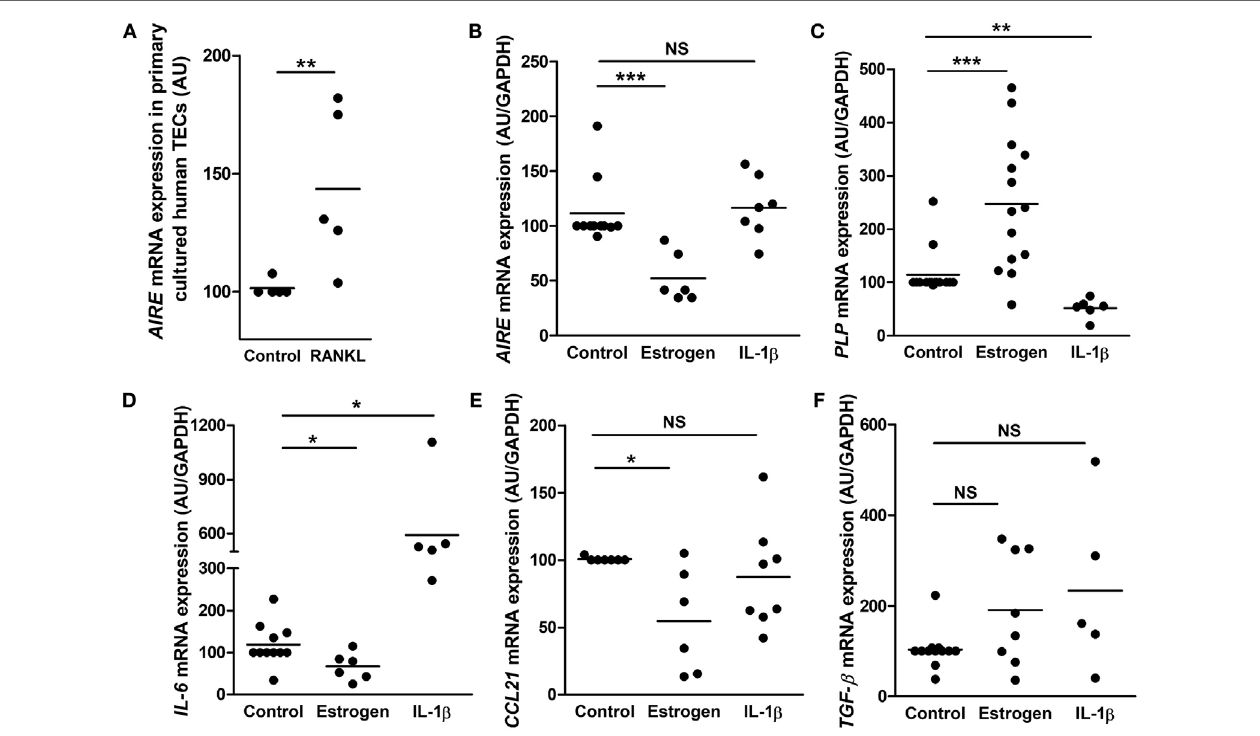
FIgURe 5 | Effect of estrogen and interleukin 1 β (Il-1 β ) on gene expression in primary cultured human thymic epithelial cells (TECs). Effect of RANKl (10 − 9 M) on AIRE mRNA expression (A) . Effect of estrogen (10 − 8 M) or Il-1 β (1 ng/ml) on the mRNA expression of AIRE (B) , myelin proteolipid protein ( PLP ) (C) , interleukin 6 ( IL-6 ) (d) , CCL21 (e) , and tumor growth factor- β ( TGF- β ) (F) in primary cultured human TECs. For each experiment, cells were incubated for 24 h. mRNA expressions were normalized to 100 in control untreated cells. Each point represents the mean value of an experiment using primary cultured TECs (day 7) obtained from different donors ( n > 5). mRNAs were analyzed by real-time PCR and normalized to GAPDH . p Values were obtained using the non-parametric Mann–Whitney test. Asterisks indicate significant differences (* p < 0.05, ** p < 0.01, and *** p < 0.001)